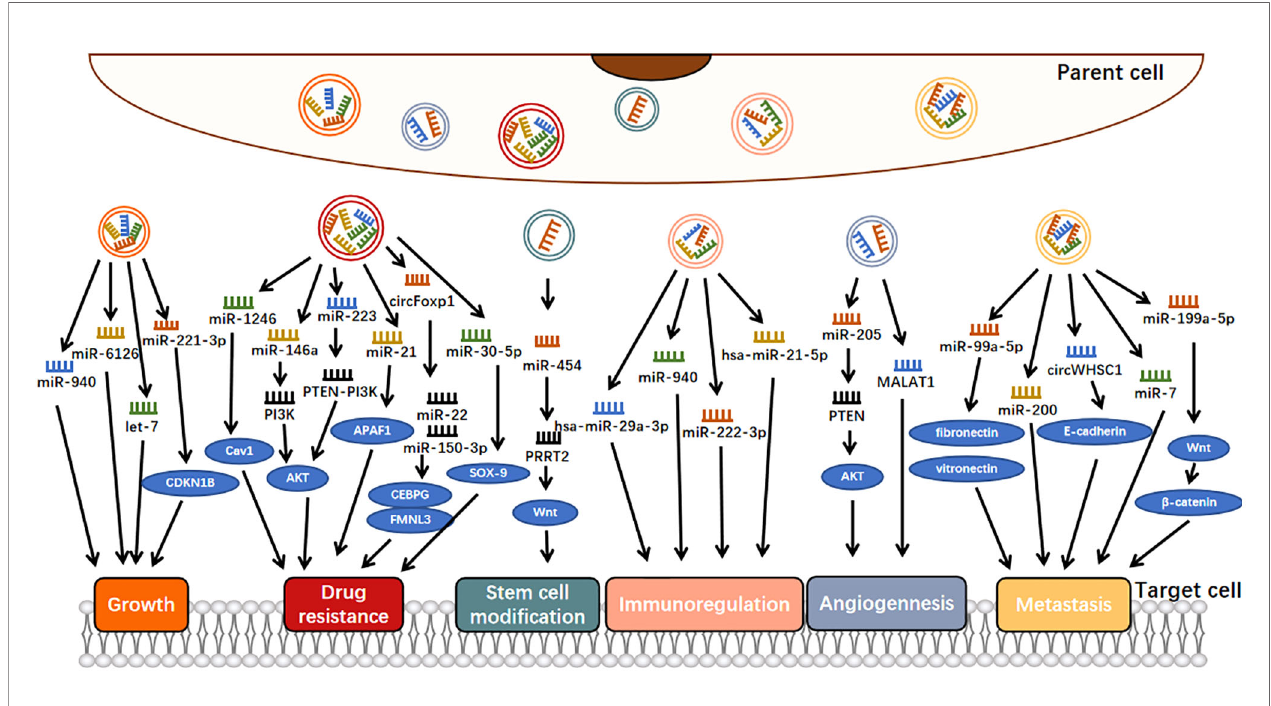
FIGURE 2 | Molecular mechanisms of exosomal ncRNAs involvement in ovarian cancer